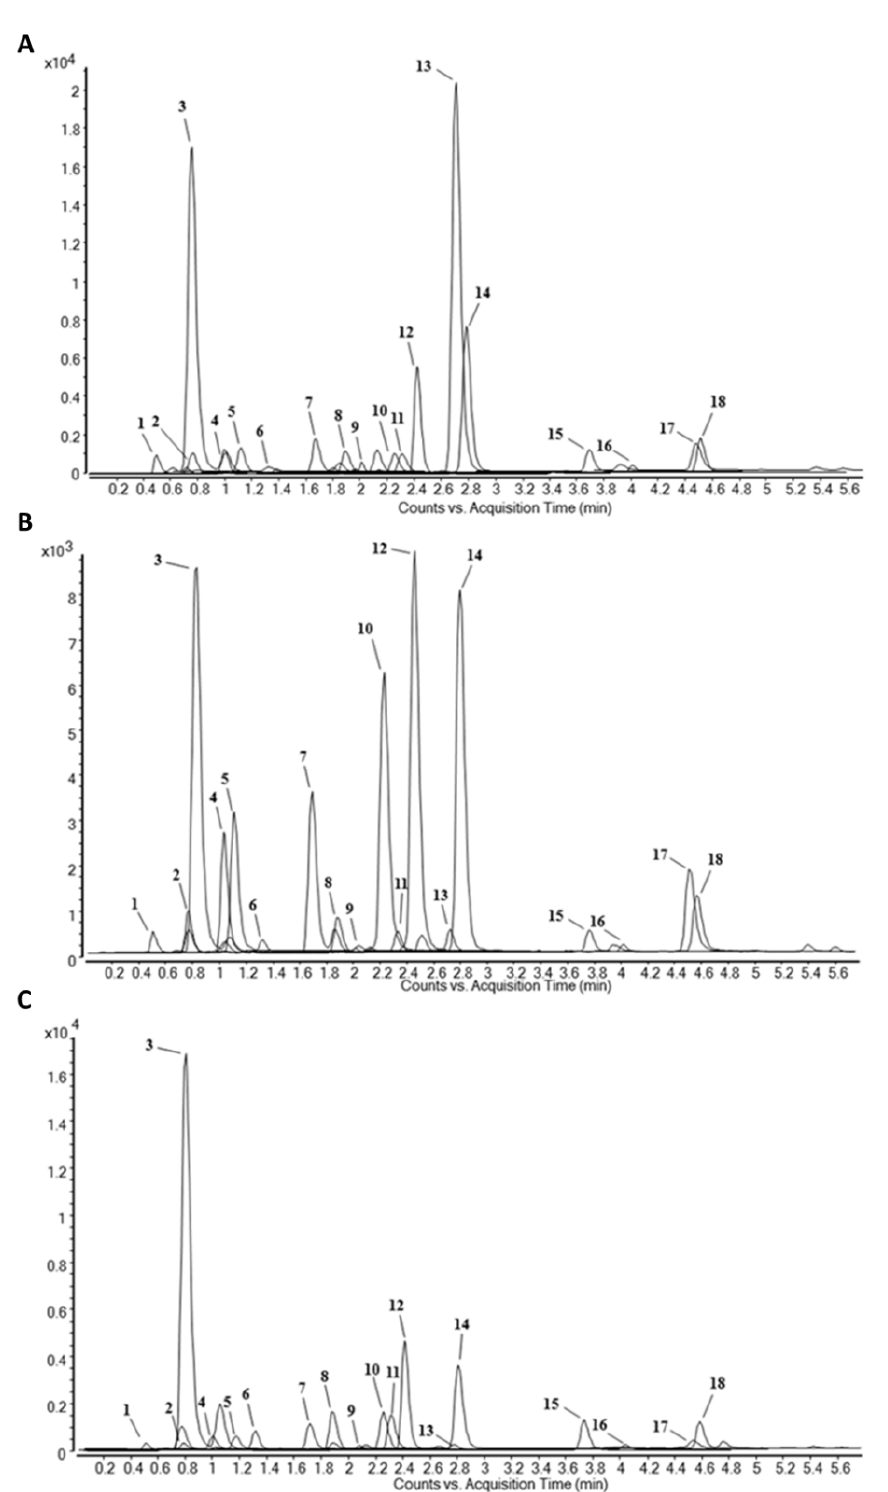
Figure 1. Chromatograms obtained by LC-ESI-MS/MS analysis of methanol extracts of flowers ( A ), leaves ( B ), and stems ( C ) of N. cataria . Found peak labels: 1 : quinic acid, 2 : protocatechuic acid, 3 : chlorogenic acid, 4 : p -hydroxybenzoic acid, 5 : caffeic acid, 6 : syringic acid, 7 : p -coumaric acid, 8 : ferulic acid, 9 : luteolin-7- O -glucoside, 10 : quercetin-3- O -glucoside, 11 : quercetin-3-O-rutinoside, 12 : rosmarinic acid, 13 : quercitrin, 14 : kaempferol-3- O -glucoside, 15 : quercetin, 16 : luteolin, 17 : kaempferol, 18 : isorhamnetin.